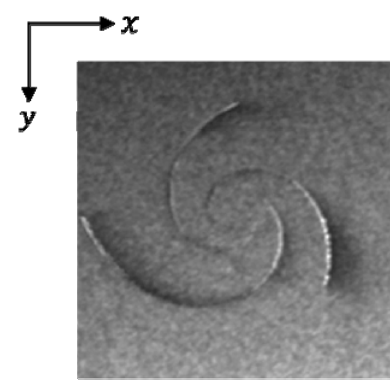
Figure 3. Flow chart of the simulation method.